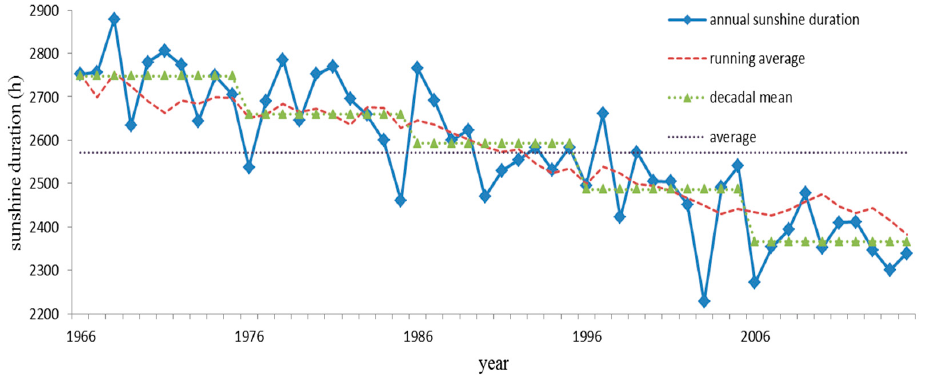
Figure 3. Variability of annual sunshine duration in the Haihe River basin during 1966–2015.